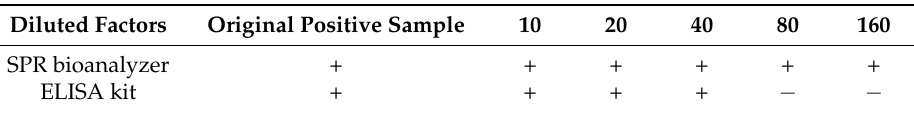
Table 1. Comparison of the sensitivity and specificity between the portable SPR bioanalyzer and the E. coli O157:H7 ELISA